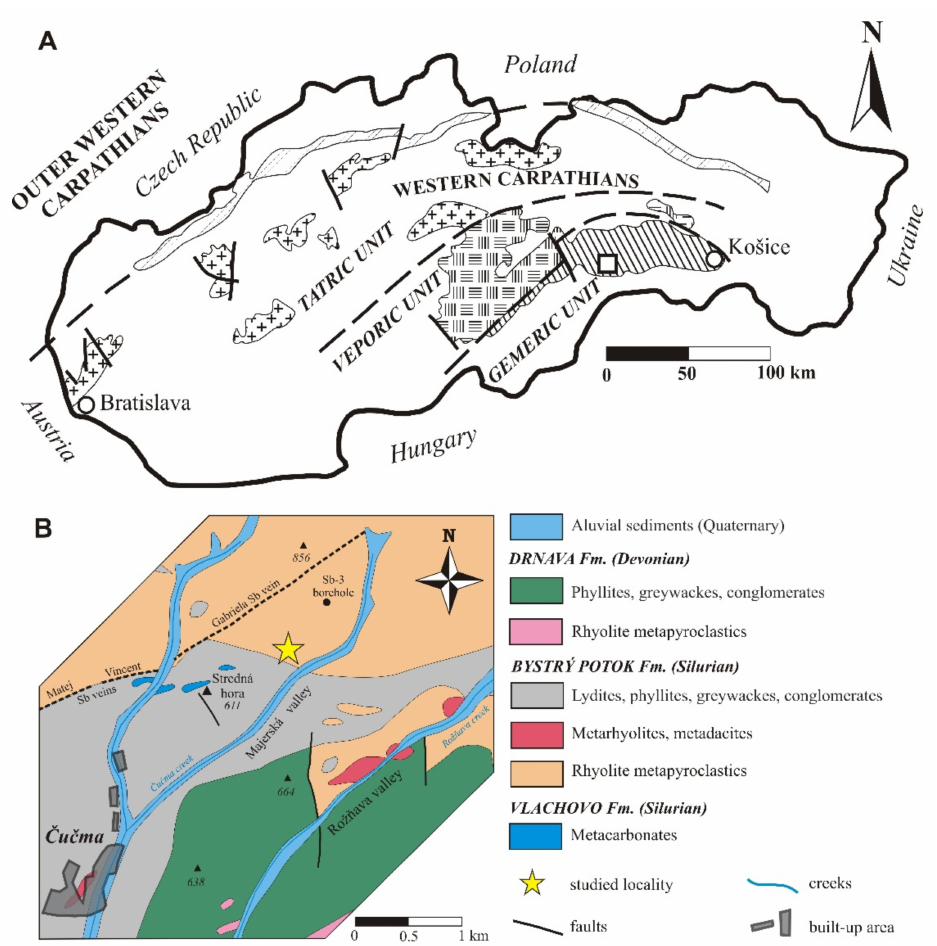
Figure 1. ( A ) Position of the studied locality (white square) within the main Alpine tectonic units of the Western Carpathians; ( B ) Geological map of the surroundings of the vein U-Mo mineralization occurrence near ˇCuˇcma. According to